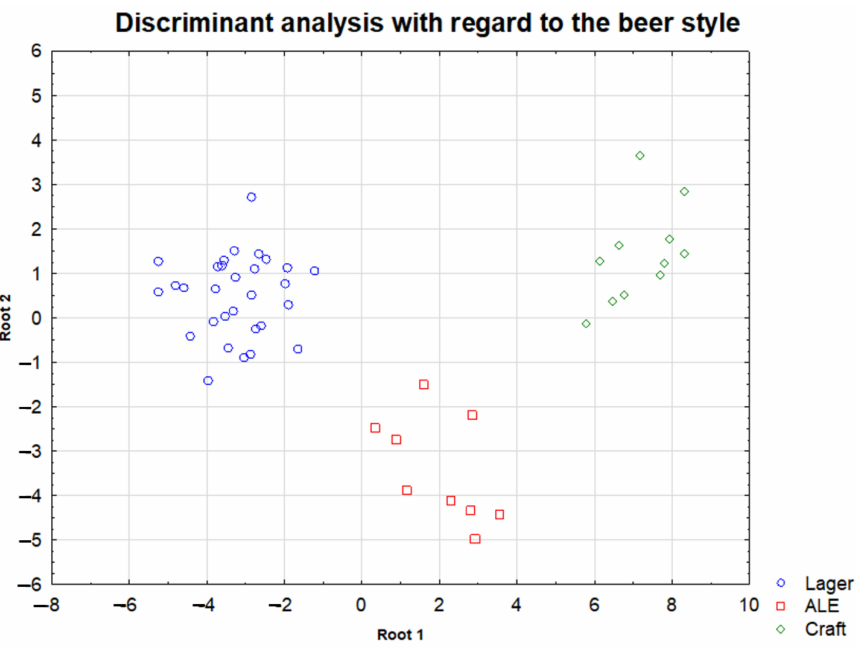
Figure 6. Discriminant analysis with regard to the beer type (Lager, Ale,